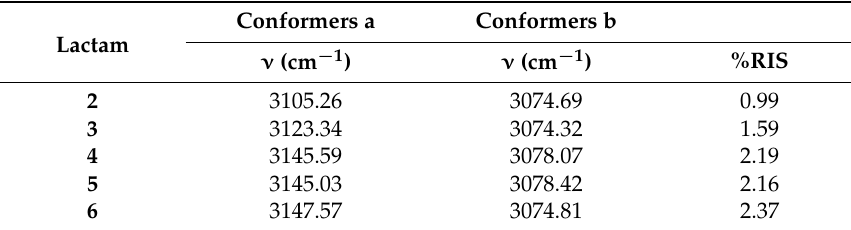
Table 4. Calculated frequencies of the fundamental C − H α stretching, and their corresponding relative infrared shifts